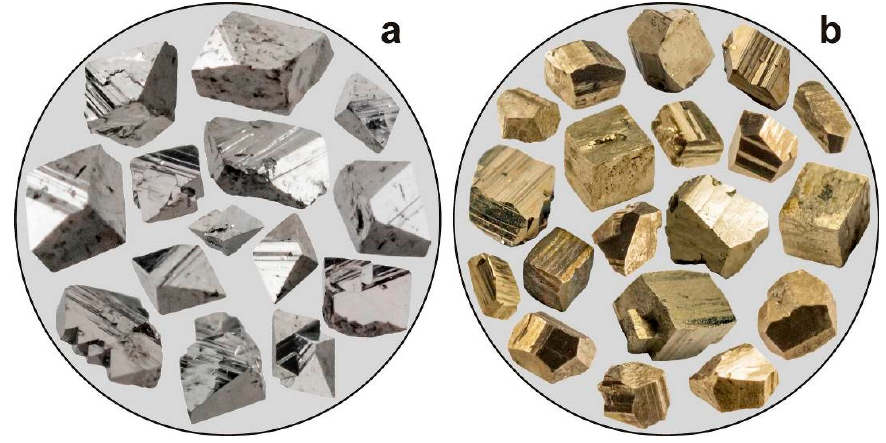
Figure 4. Crystals: ( a ) arsenopyrite, ( b ) pyrite.